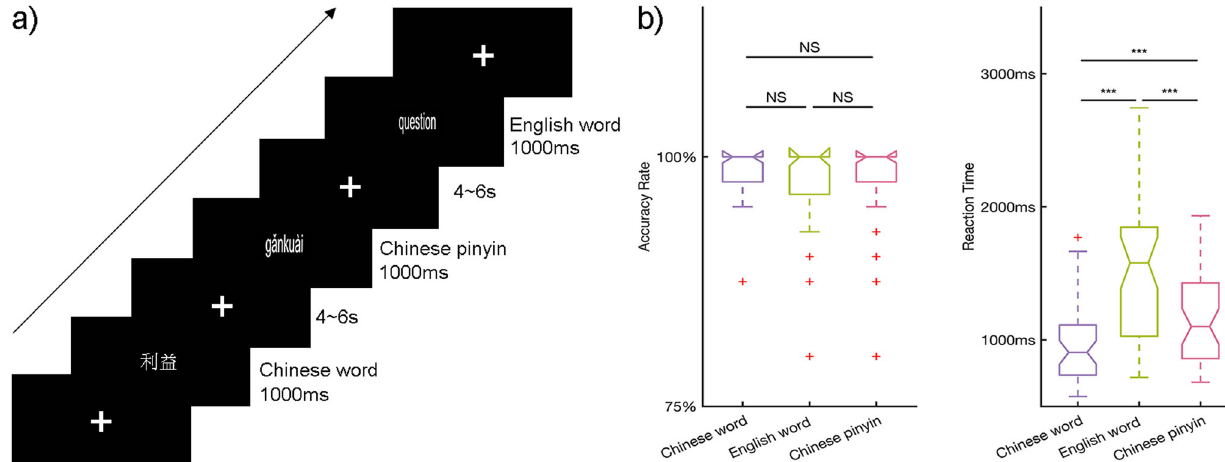
Fig. 1 Experimental design and task performance. a An event-related design was utilized in the current study. Visual stimuli of Chinese word, English word, and Chinese pinyin reading tasks were presented for 1000 ms in randomized order with an inter-stimulus interval of 4 – 6 s. Responses by participants were required to identify language types after semantic access. b Accuracy rate and reaction time for Chinese word, English word, and Chinese pinyin reading tasks. Reaction time was counted from the onset of visual stimuli to the button-press response. A one-way ANOVA was conducted to test signi fi cant differences between language types. No signi fi cant differences were found between accuracy rates due to the ceiling effect but signi fi cant differences were found between reaction times. Post hoc analysis (Bonferroni corrected, p < 0.05) revealed the longest reaction time for accessing the semantics of Chinese pinyin and the shortest time for Chinese